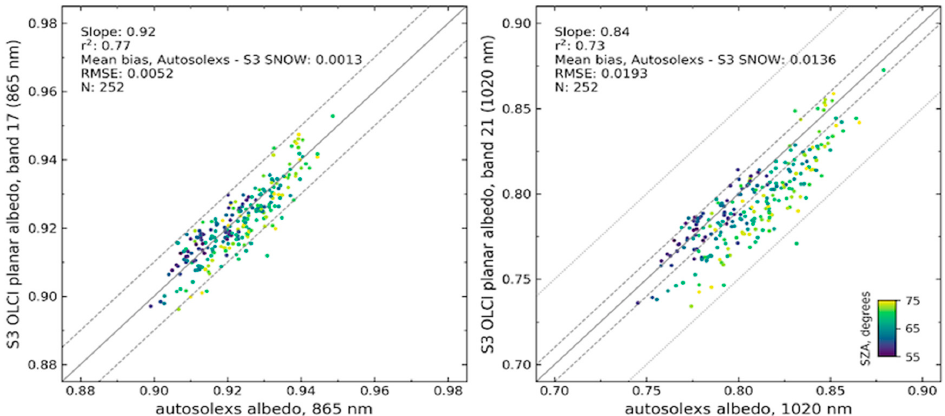
Figure 10. Scatterplot of the relationship between Sentinel-3 OLCI spectral planar albedo retrievals and the concurrent spectral albedo measured with the Autosolexs instrument at 2 OLCI bands (865, and 1020 nm). The thin dashed lines running on each side of the identity line represent y = x ± 0.01, and the thin dotted lines in the right panel represent y = x ± 0.05. Table 2. Location, Sentinel-3 acquisition dates and times, and SZA values for the sites along the ASUMA traverse used for the validation of the spectral albedo products.